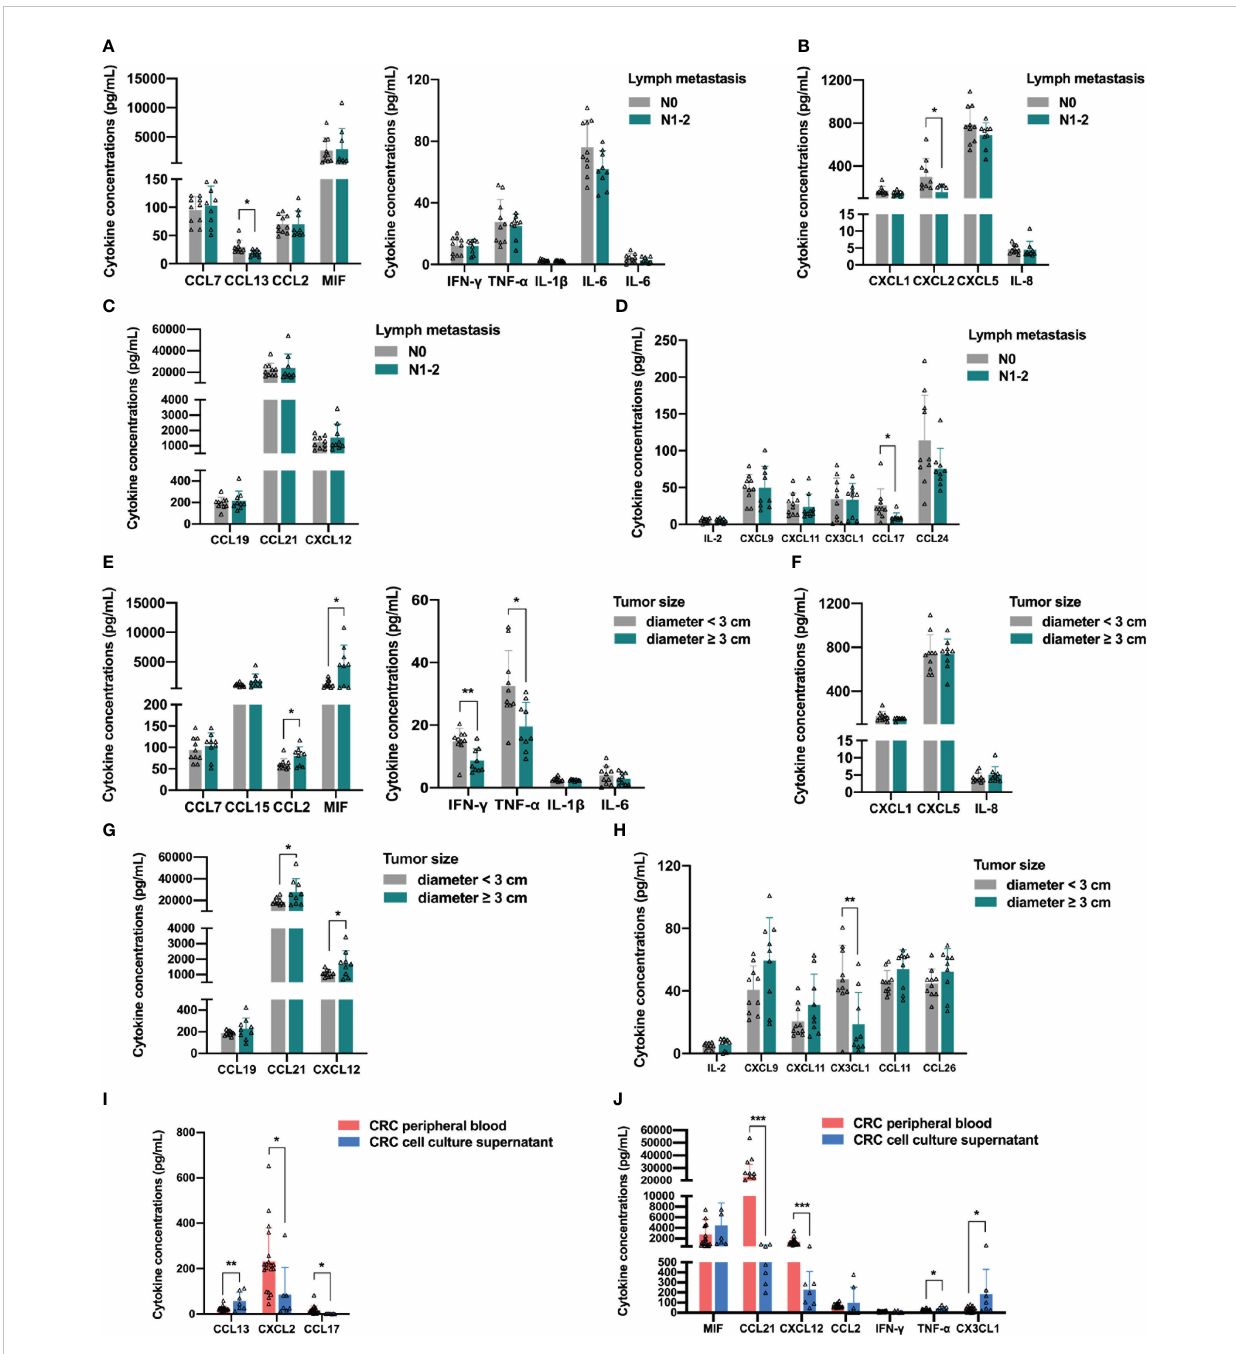
FIGURE 6 Relationship between distribution of peripheral blood cytokines and lymph node metastasis or primary tumor size in colorectal cancer patients. (A) Analysis of the monocyte-macrophage system associated cytokines. The concentration of monocyte chemotactic protein CCL13 was lower in the N1-2 group than in the N0 group. (B) Analysis of the neutrophil-associated cytokines. The concentration of CXCL2 was lower in the N1-2 group than in the N0 group. (C) The analysis of dendritic cell-related cytokines showed no signi fi cant differences between the two groups. (D) Analysis of the lymphocyte-associated cytokines. The concentration of CCL17 was lower in the N1-2 group than in the N0 group. (E) Analysis of the monocyte- macrophage system associated cytokines. CCL2 and MIF were signi fi cantly upregulated in the tumor diameter ≥ 3 cm group, and IFN- g and TNF- a were signi fi cantly downregulated in the tumor diameter ≥ 3 cm group. (F) The analysis of the neutrophil-associated cytokines showed no signi fi cant differences between the two groups. (G) Analysis of the antigen-presenting cells-related cytokines. CCL21 and CXCL12 were signi fi cantly upregulated in the tumor diameter ≥ 3 cm group. (H) Analysis of the lymphocyte-associated cytokines. CX3CL1 was signi fi cantly downregulated in the tumor diameter ≥ 3 cm group. (I, J) Analysis of the differential cytokines. The concentration of CXCL2, CCL17, CCL21 and CXCL12 were signi fi cantly lower in CRC cell line culture supernatant than in CRC patients ’ peripheral blood. Data are presented as mean±SD, Student ’ s t-test, * p <0.05, ** p <0.01, *** p